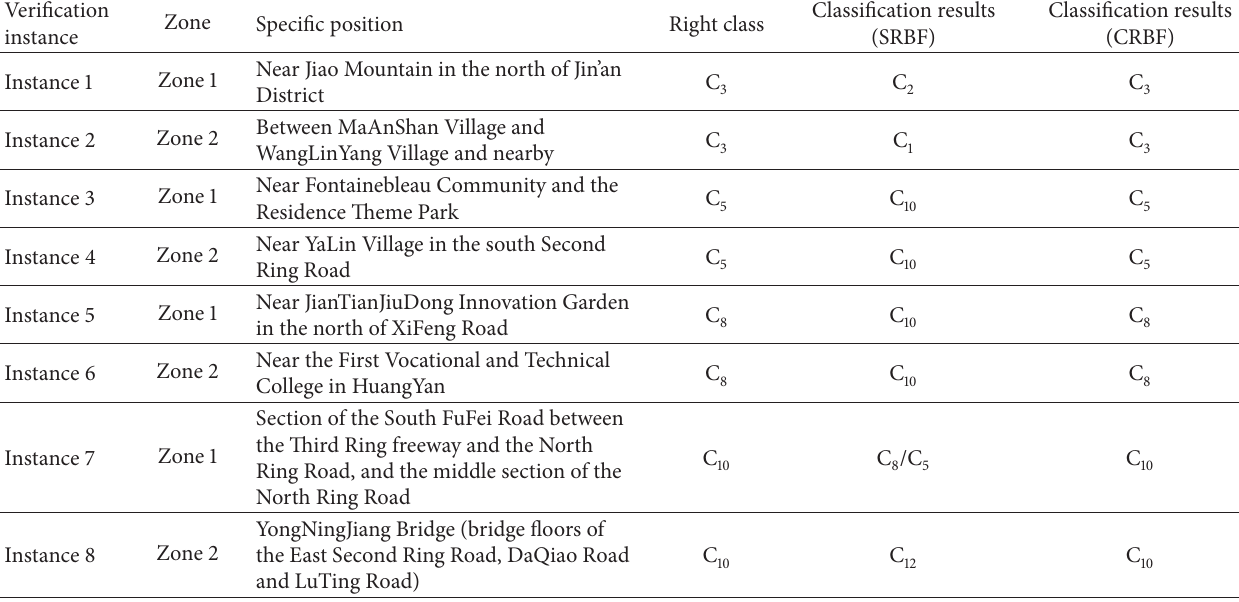
Table 10: CRBF-based BDT-SMO classification